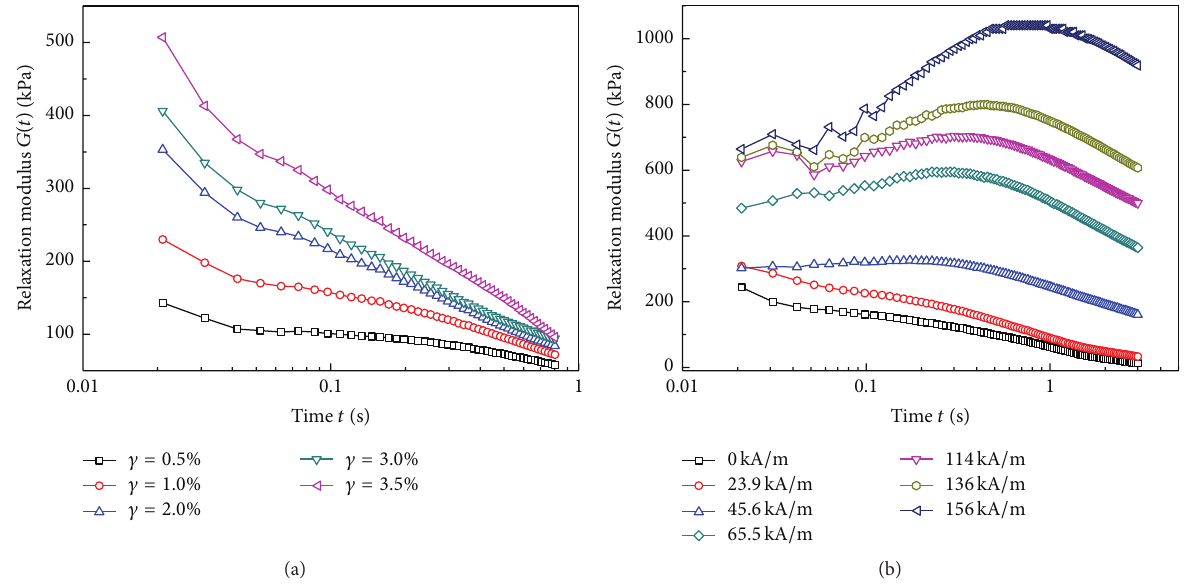
Figure 4: The relaxation property of MRSP-4 (a) on the condition of different initial strain (b) on the condition of different external magnetic field